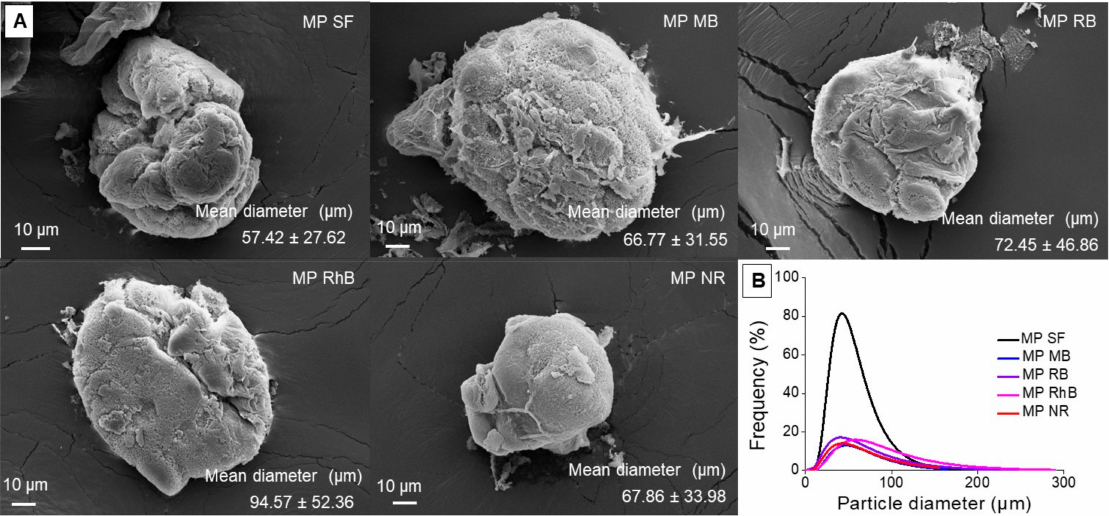
Figure 1. ( A ) Scanning electron microscopy micrograph of silk fibroin (SF) microparticle produced by the atomization method with and without dye loading. The inset values show the mean particle diameter. ( B ) Log-Normal of particle size distribution of SF microparticles.